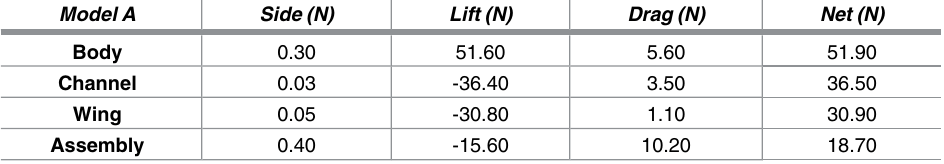
Table 1. Component and net tag force contributions from the individual flow control elements for the Model A design in 5.6 m/s